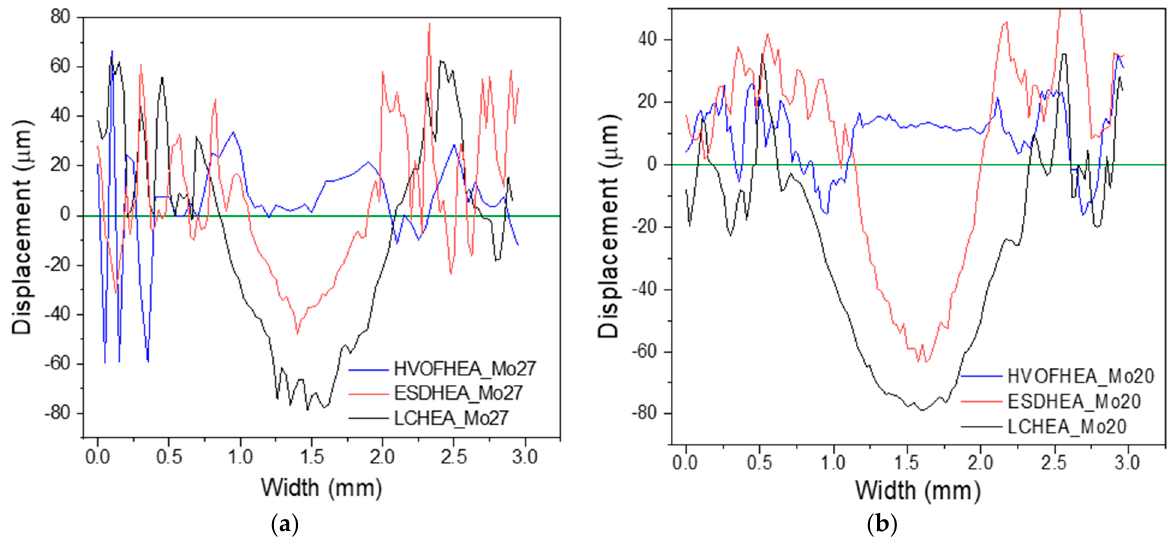
Figure 10. The topography profiles of the HEA coatings with the different deposition techniques after 12,000 wear cycles under dry test condition ( a ) HEA_Mo 27 and ( b ) HEA_Mo 20 .